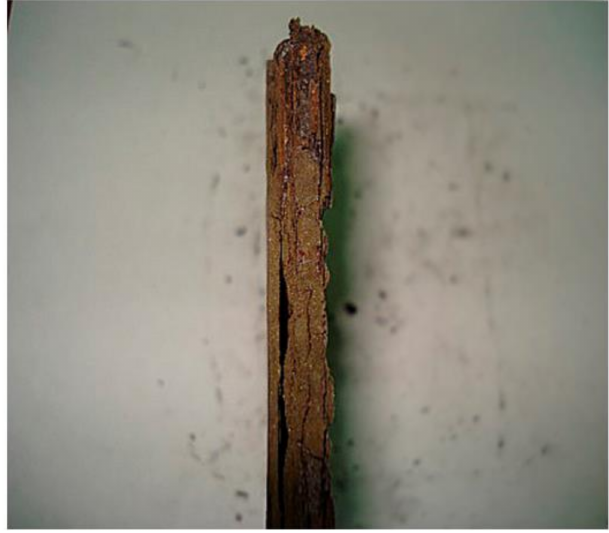
Figure 5. Optical macrograph of the exfoliation present in the exposed probe at the Quintero station after 36 months of